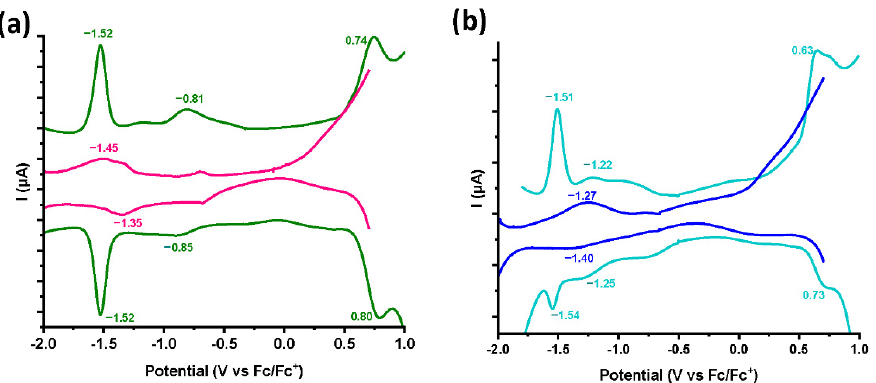
Figure 4. Square wave voltammetry (SWV) assays of ( a ) pyridine/Co(III) (green) and [Co]-pyr- graphene (pink) and ( b ) imidazole/Co(III) (teal) and [Co]-imi-graphene (blue), recorded in N 2 -saturated dry DMF and 0.1 M TBAPF 6 . Pt wire and Pt cloth were used as reference and counter electrode, respectively, while a Pt button electrode was used as the working electrode. Table 1. Square wave voltammetry (SWV) data for pyridine/Co(III), imidazole/Co(III), [Co]-pyr- graphene and [Co]-imi-graphene recorded in N 2 -saturated 0.1 M TBAPF 6 in dry DMF. Material/Compound